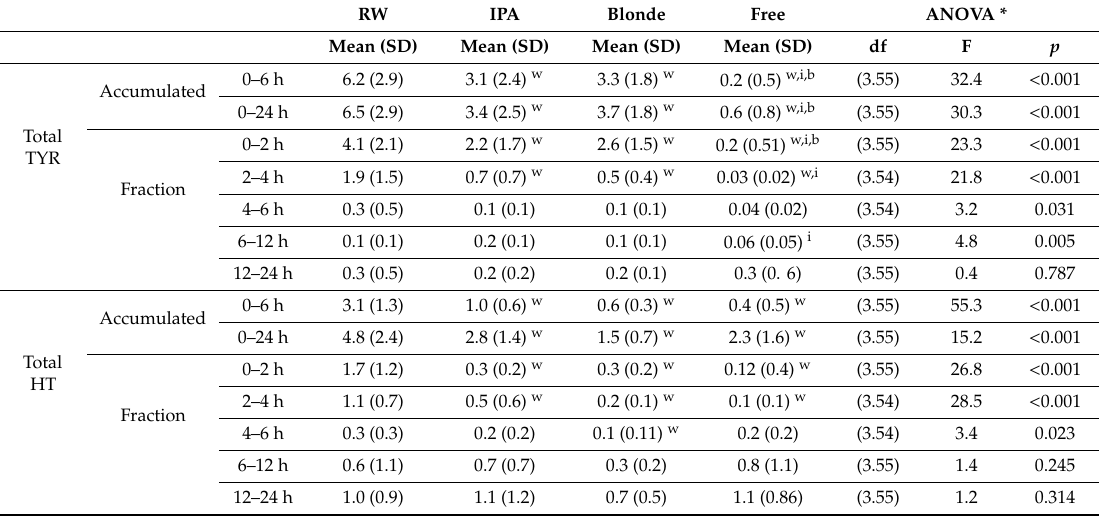
Table 4. Total TYR and HT urinary recovery by fractions of 0–2, 2–4, 4–6, 6–12, and 12–24 h and the total recovery during the first 6 and 24 h post-administration of the di ff erent treatments. Results are expressed in µ